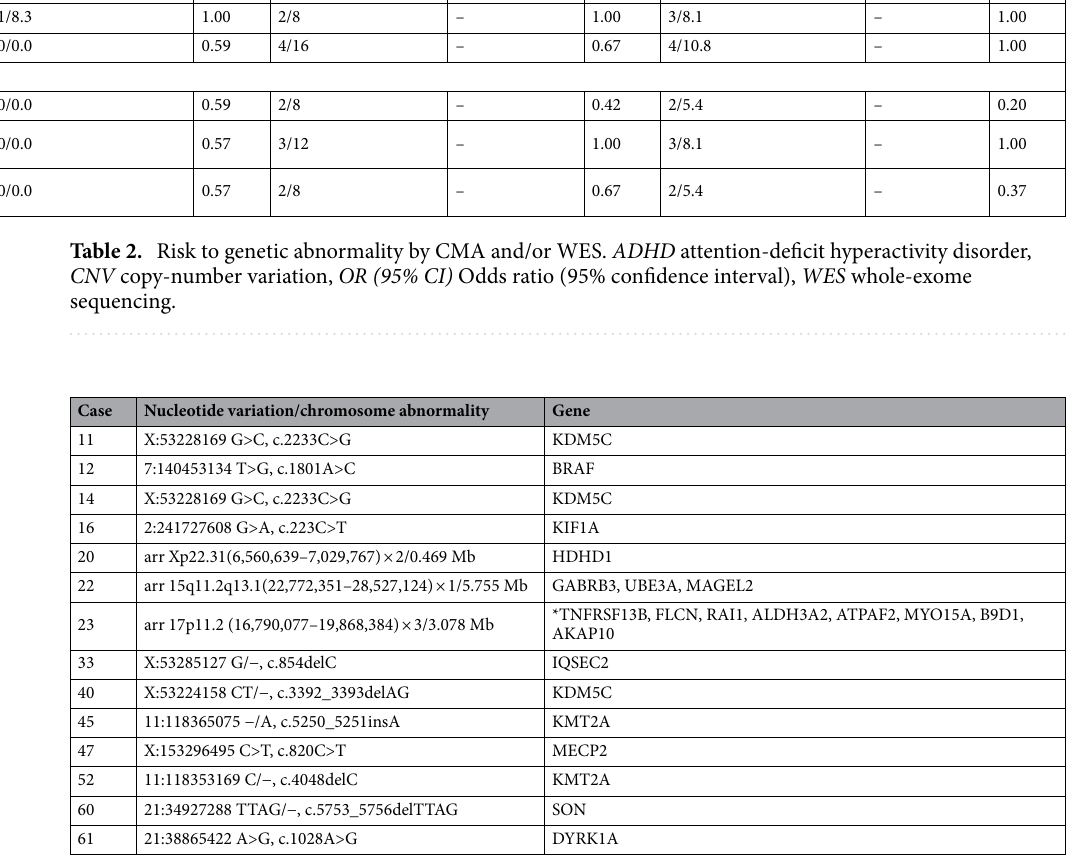
Table 3. Nucleotide variation/CNV abnormality list in 14 patients with autistic spectrum disorder. CNV copy- number variation. *Disease genes on